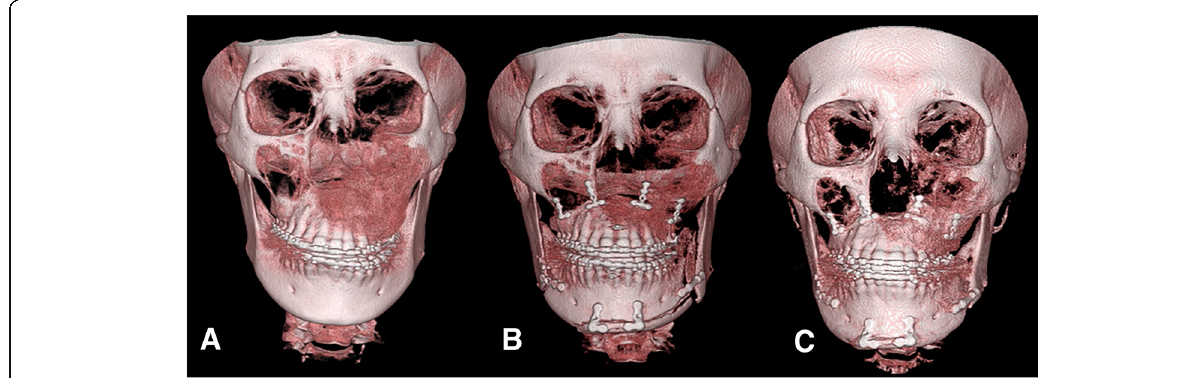
Fig. 1 3D CT image of patient no. 1 preoperative ( a ) immediately postoperative ( b ) and 1 year postoperative status ( c ) showing improvement in occlusal canting following Le Fort I and wing osteotomy on the mandibular body and chin with rigid